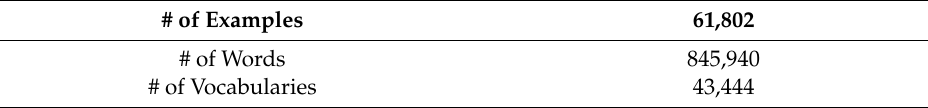
Table 4. Statistics of the emotion corpus.